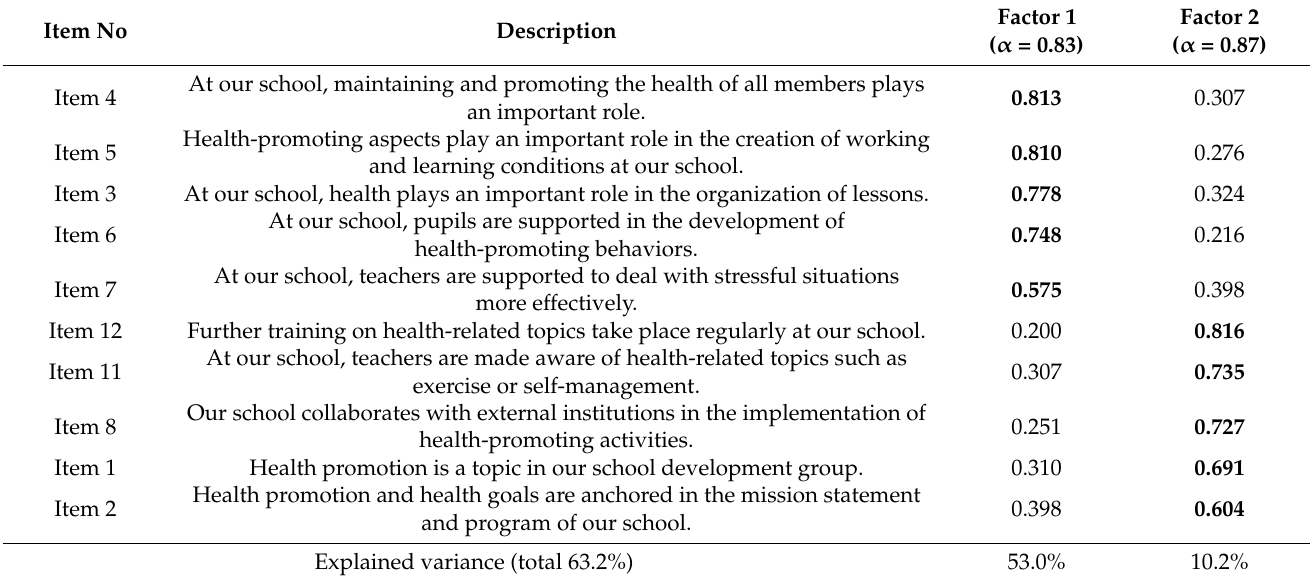
Table 3. Factor loadings of the final HPS implementation instrument with 10